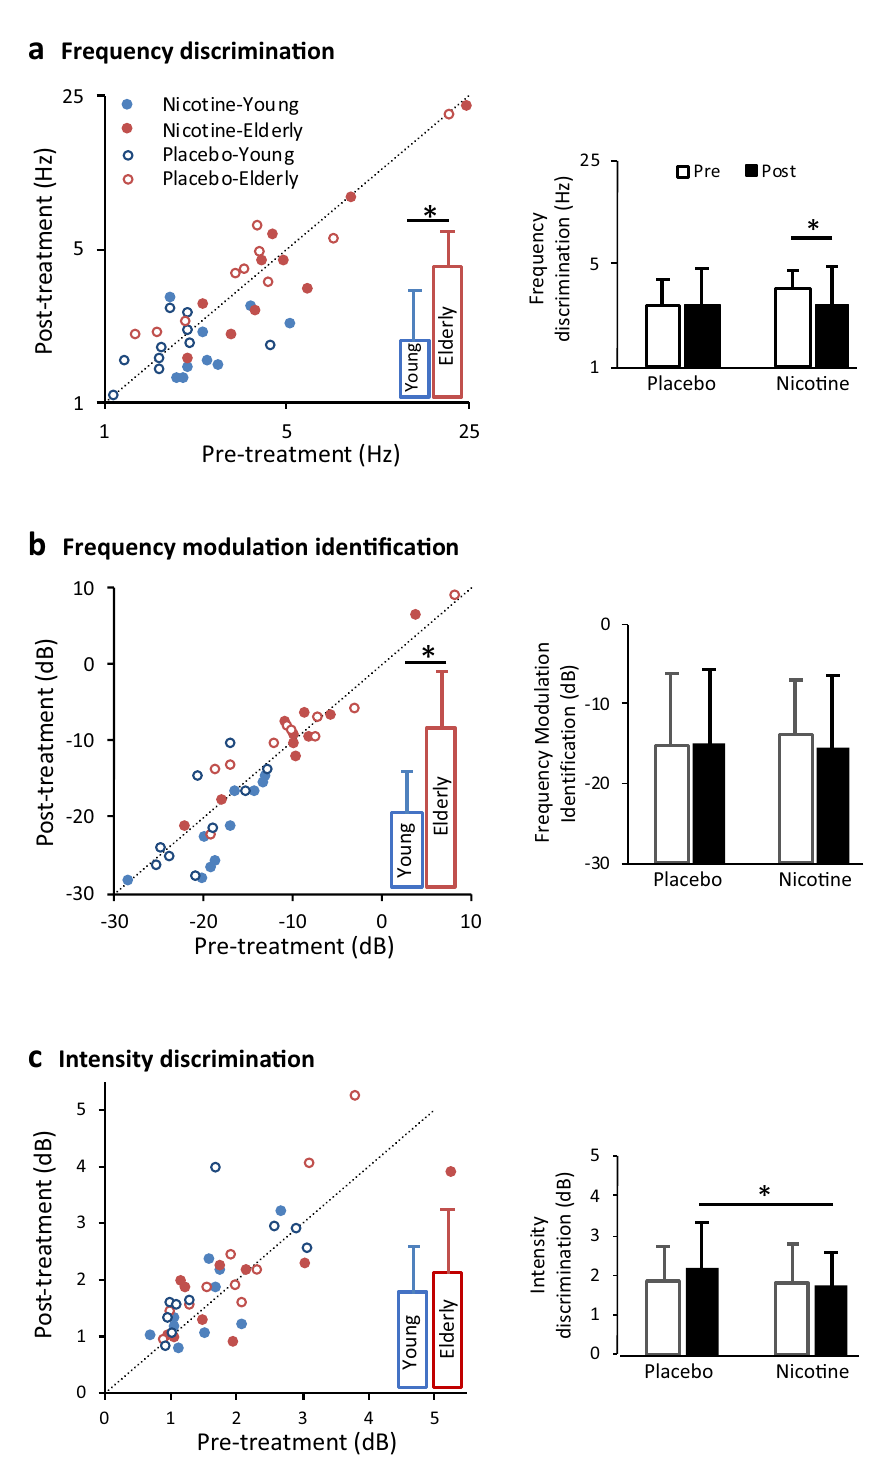
Figure 1. Post- versus pre-treatment performance for three auditory tasks. (a) Frequency discrimination thresholds at 500 Hz. The left panel shows individual results from both nicotine (filled circles) and placebo (open circles) conditions for young (blue) and elderly adults (red). Data points below the diagonal line indicate improved post-treatment performance, whereas points above denote worsened performance. The insert in the left panel shows between-subjects comparisons between young (blue bar) and elderly (red bar) adults. The right panel shows 2 × 2 within-subjects comparisons between the treatment (nicotine vs. placebo on the x-axis) and time (pre- vs. post-treatment = open vs. filled bars) factors. Error bars represent one standard deviation. The asterisk above the line indicates a significant difference between the two conditions. (b) Frequency modulation identification results are displayed following the same convention as ( a). (c) Intensity discrimination results are displayed following the same convention as (